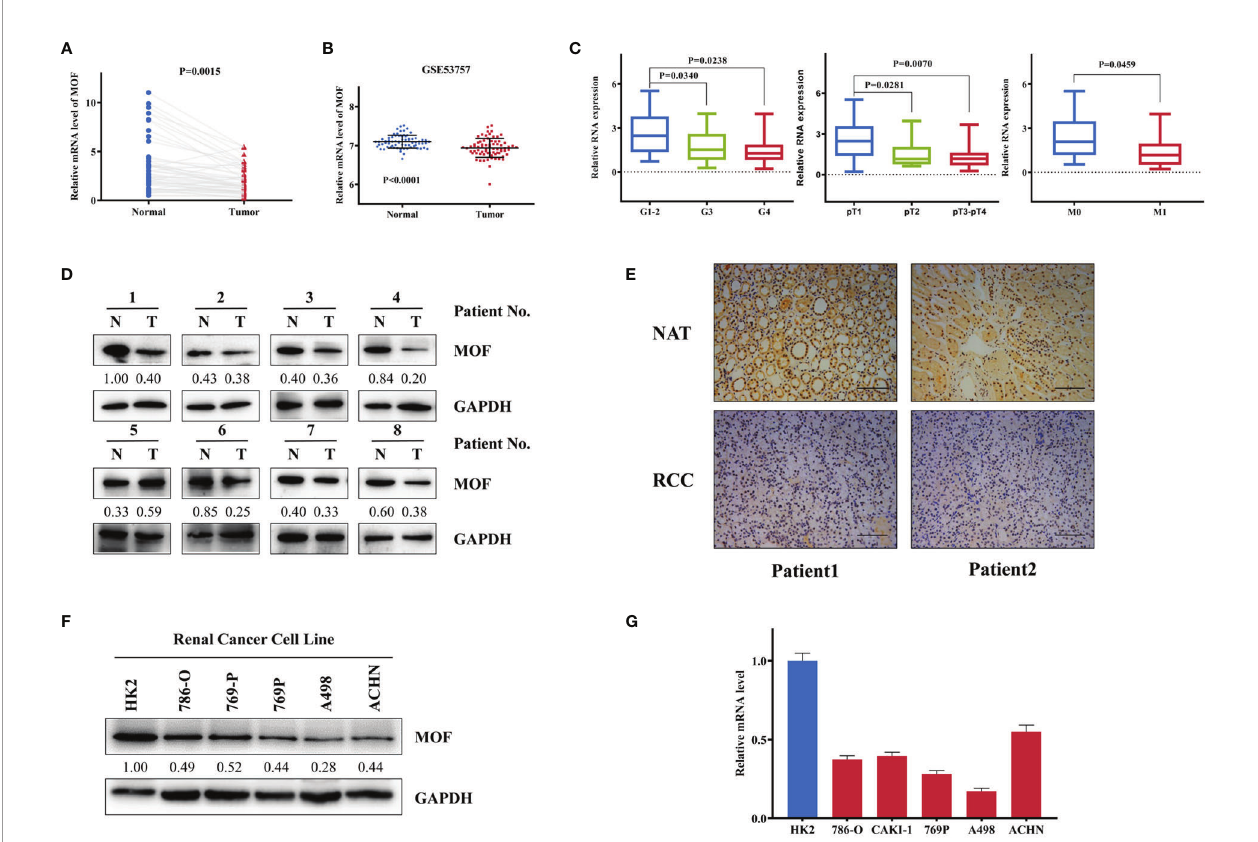
FIGURE 1 | MOF is downregulated in renal cell carcinoma tissues and cells. (A) MOF RNA level is decreased in renal cell carcinoma tissues (n=52) compared to normal tissues (n=52). (B) MOF expression level is down-regulated in renal cell carcinoma tissues (n=72) compared to normal tissues (n=72) according to GSE53757 database. (C) The expression of MOF was decreased in renal cell carcinoma tissues with advanced histological grade, pathologic tumor stage and distant metastasis. (D) MOF protein level is decreased in most renal cell carcinoma tissues. (E) The expression of MOF is reduced in renal cell carcinoma tissues. Scale bar, 100 m m. (F, G) MOF protein (F) and RNA (G) level is down-regulated in renal cell carcinoma